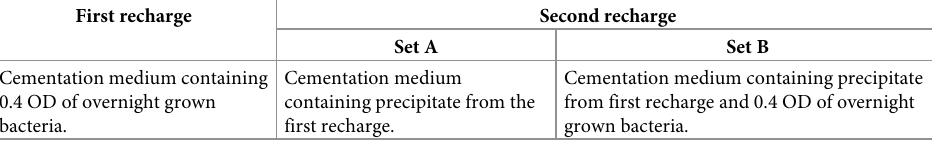
Table 2. Experimental design to study the influence of cells on the kinetics of CaCO 3 precipitation after the subse- quent recharge of cementation medium. First recharge Second recharge Set A Set B Cementation medium containing Cementation medium Cementation medium containing precipitate 0.4 OD of overnight grown containing precipitate from the from first recharge and 0.4 OD of overnight bacteria. first recharge. grown